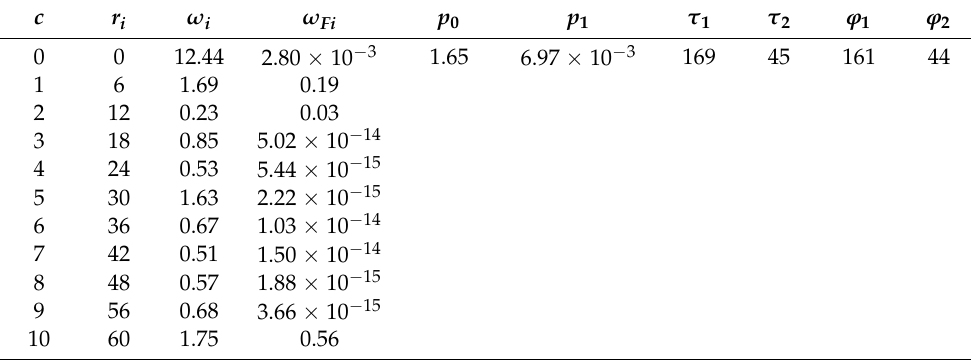
Table 3. The result of parameter